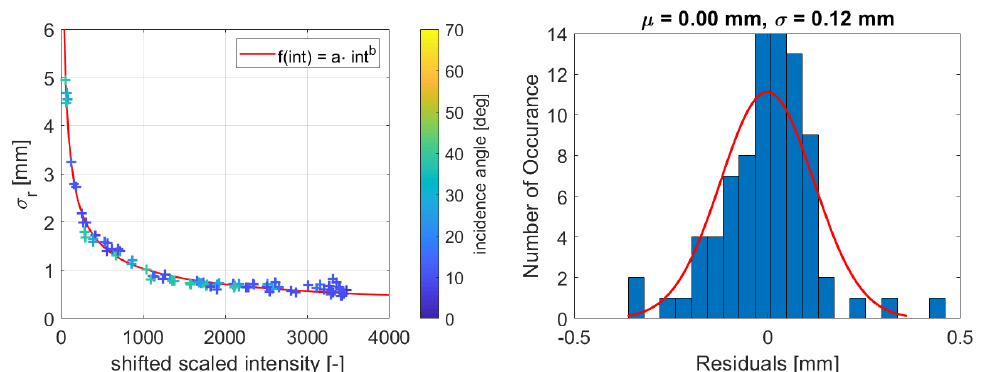
Figure 10. Left : Estimated function for Leica ScanStation P20 and resolution of 0.8 mm @ 10 m; Right : Corresponding histogram of the residuals of the